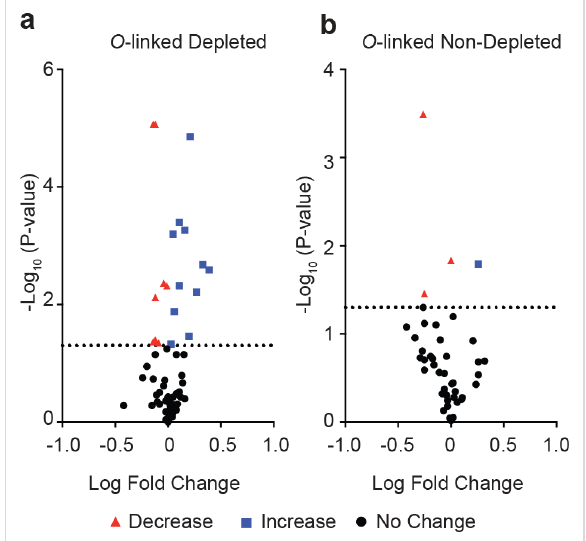
Figure 4: O -Glycoproteome profiling with GlypNirO. Volcano plots of site-specific O -glycoform relative abundance in HCC patients versus healthy controls in (a) depleted, and (b) non-depleted